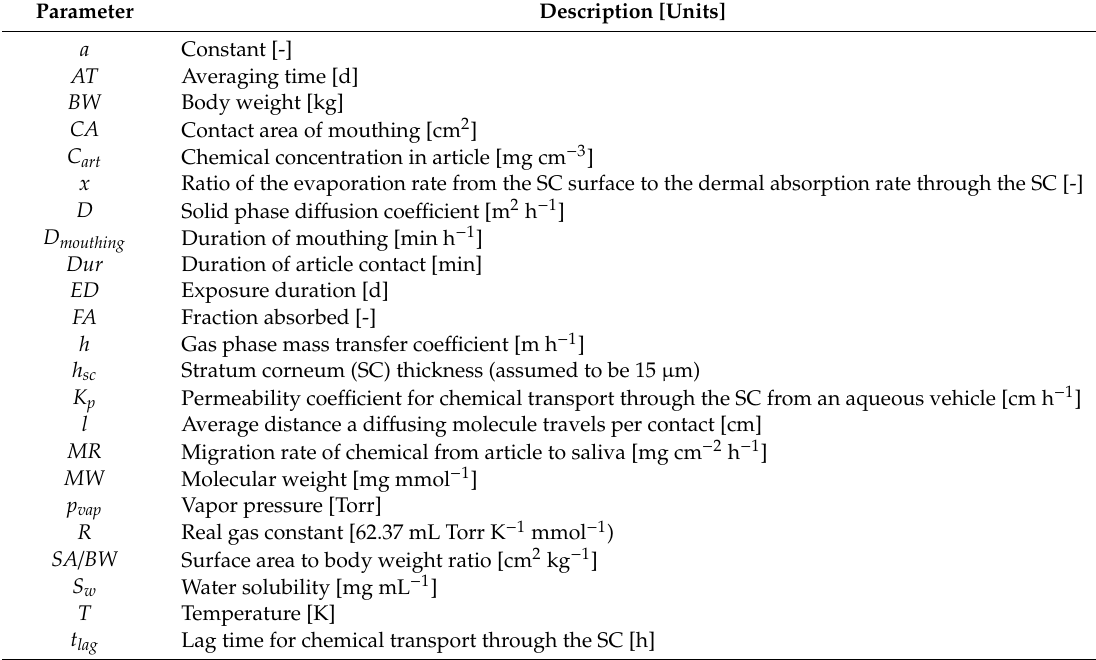
Table 2. Input parameters for the estimation of